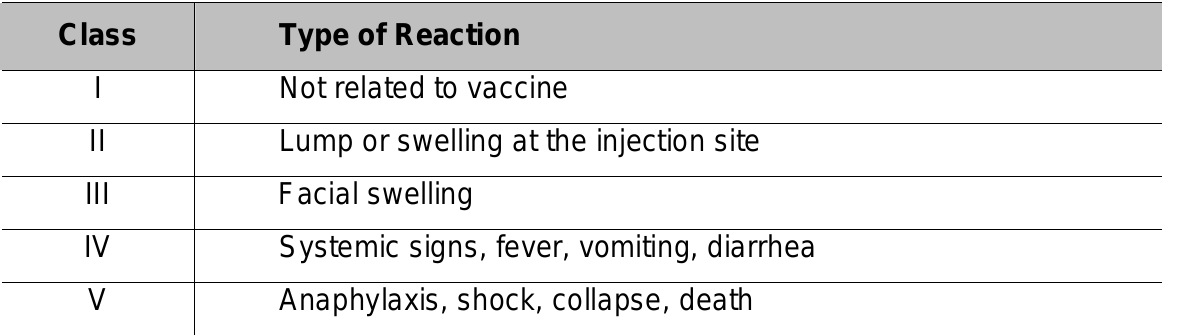
Table 1. Post-vaccination adverse reactions